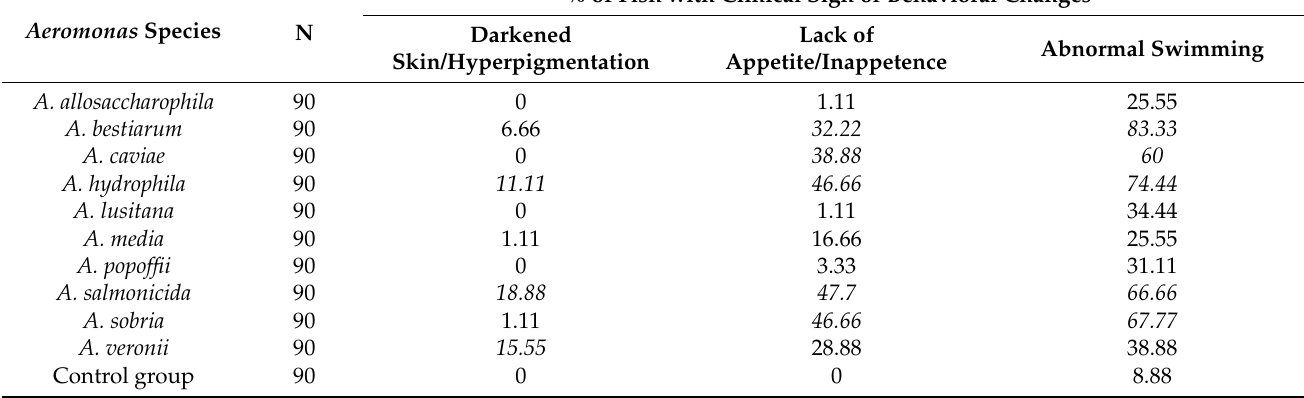
Table 2. Percentages of clinical signs or behavioral changes, present in fingerlings experimentally infected with different Aeromonas